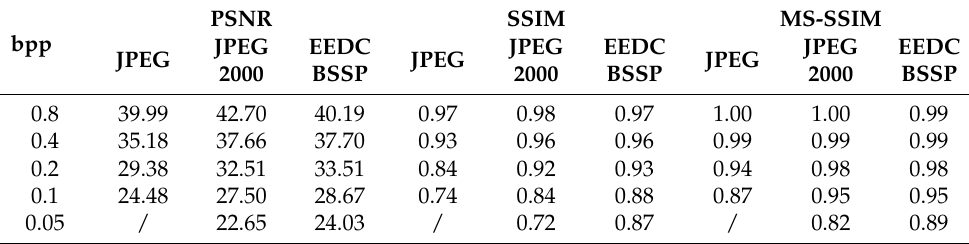
Table 10. Results of the PSNR, SSIM, and MS-SSIM metrics for image horse . PSNR bpp